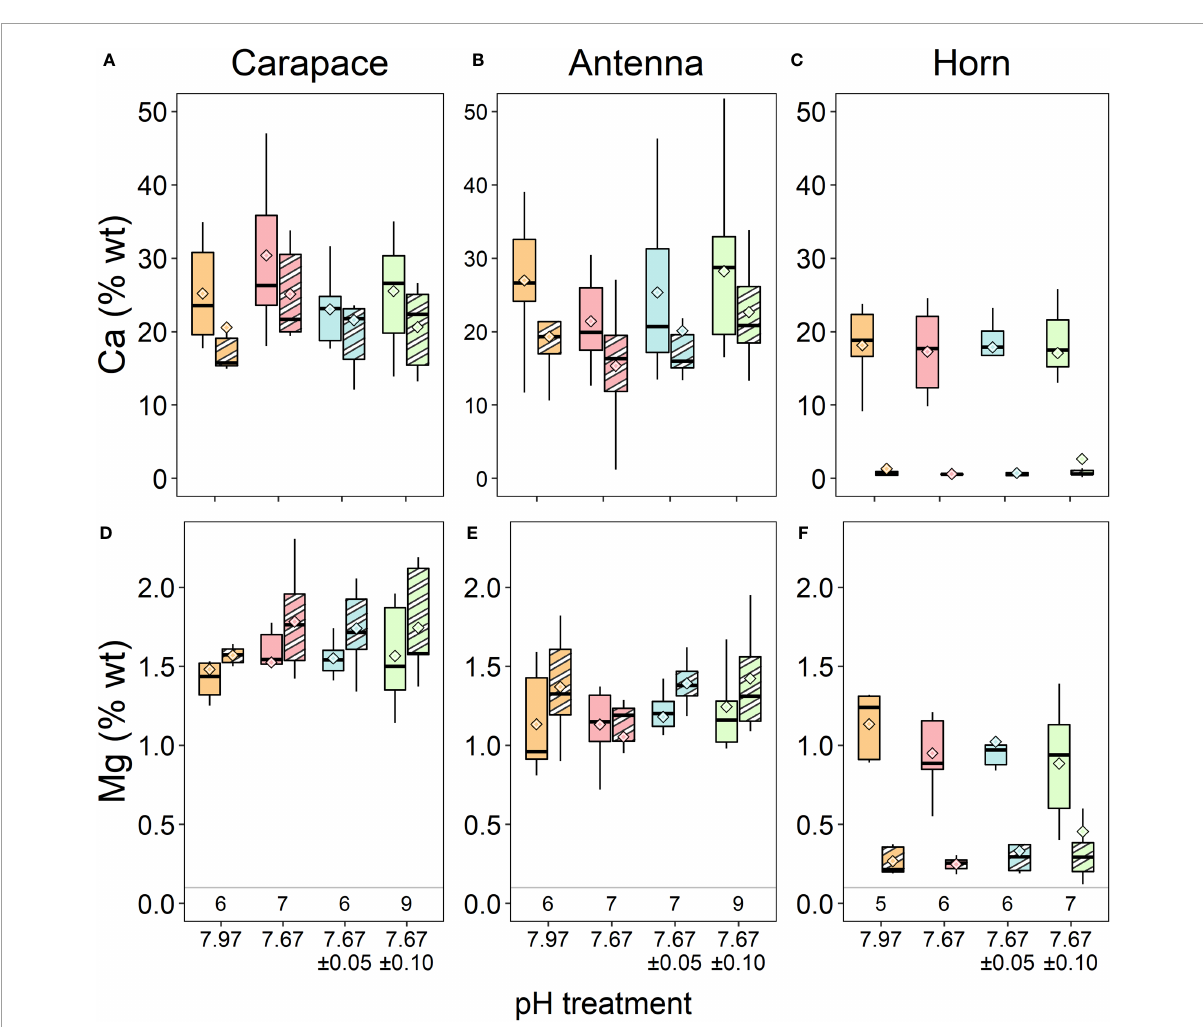
FIGURE 3 Calcium and (A-C) Mg (D-F) % wt of three exoskeletal structures from EDX measurements. There were no significant differences in either element across treatment conditions. Each structure’s exocuticle, or the outer layer in the case of the horn, is represented as the right boxes of each treatment (striped shades), and the endocuticle layers or core of the horn are the left boxes of each treatment (solid shades). Box boundaries are the first and third quartiles, whiskers are 1.5 times the interquartile range, the center line is the median, and black and white diamonds are the mean. Values on the bottom of panels (D-F) denote sample size for each